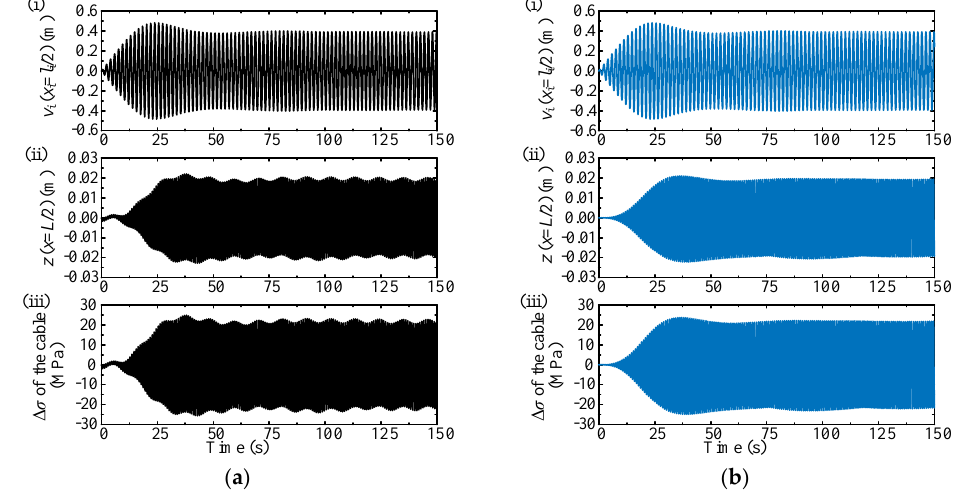
Figure 3. Responses of SFT due to the vortex-induced vibration (VIV) of the cable: ( a ) with wave force on SFT tube; ( b ) without wave force on SFT tube; (i) displacement in the mid-section of cable; (ii) displacement in the mid-span of tube; (iii) cable stress variation (Δ σ ).